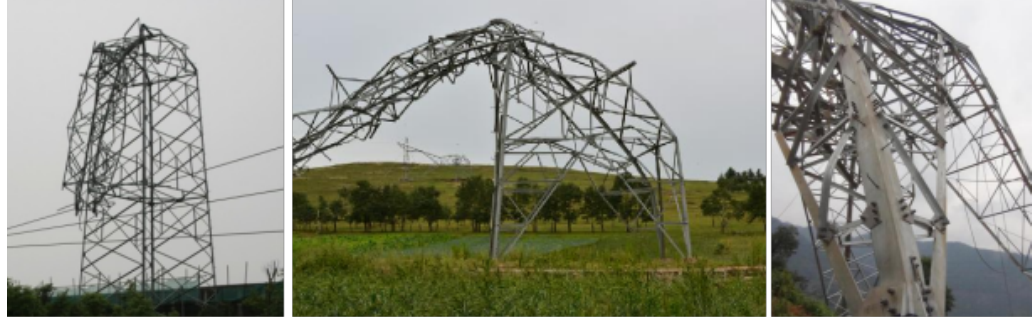
Figure 1: Collapse accidents of transmission tower